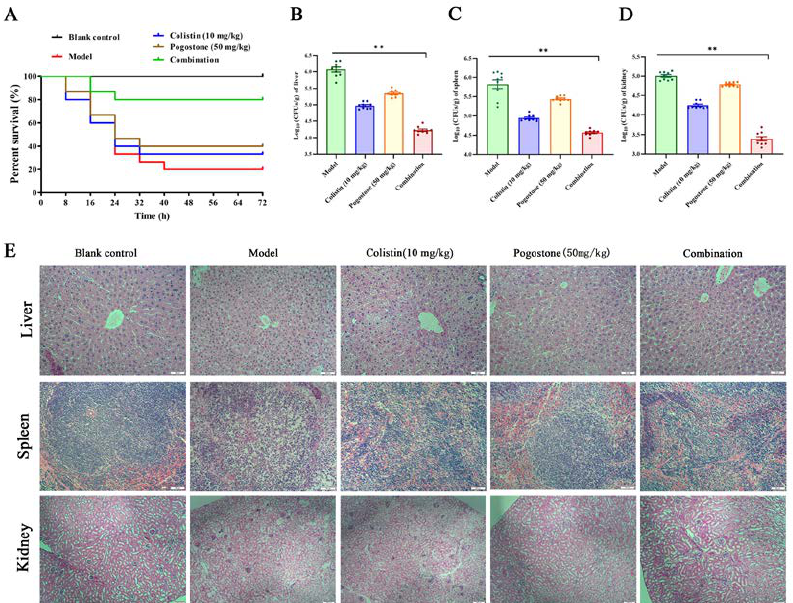
Figure 6 . Effects of the combination therapy with colistin and pogostone in vivo. The mice were infected by intraperitoneal injection with E. coli ZJ478. The survival rate ( A ) and the bacterial loading of the liver, spleen, and kidney were calculated ( B – D ). The histopathological changes of liver, spleen, and kidney of the mice in different groups are shown in ( E ). ** p < 0.01.